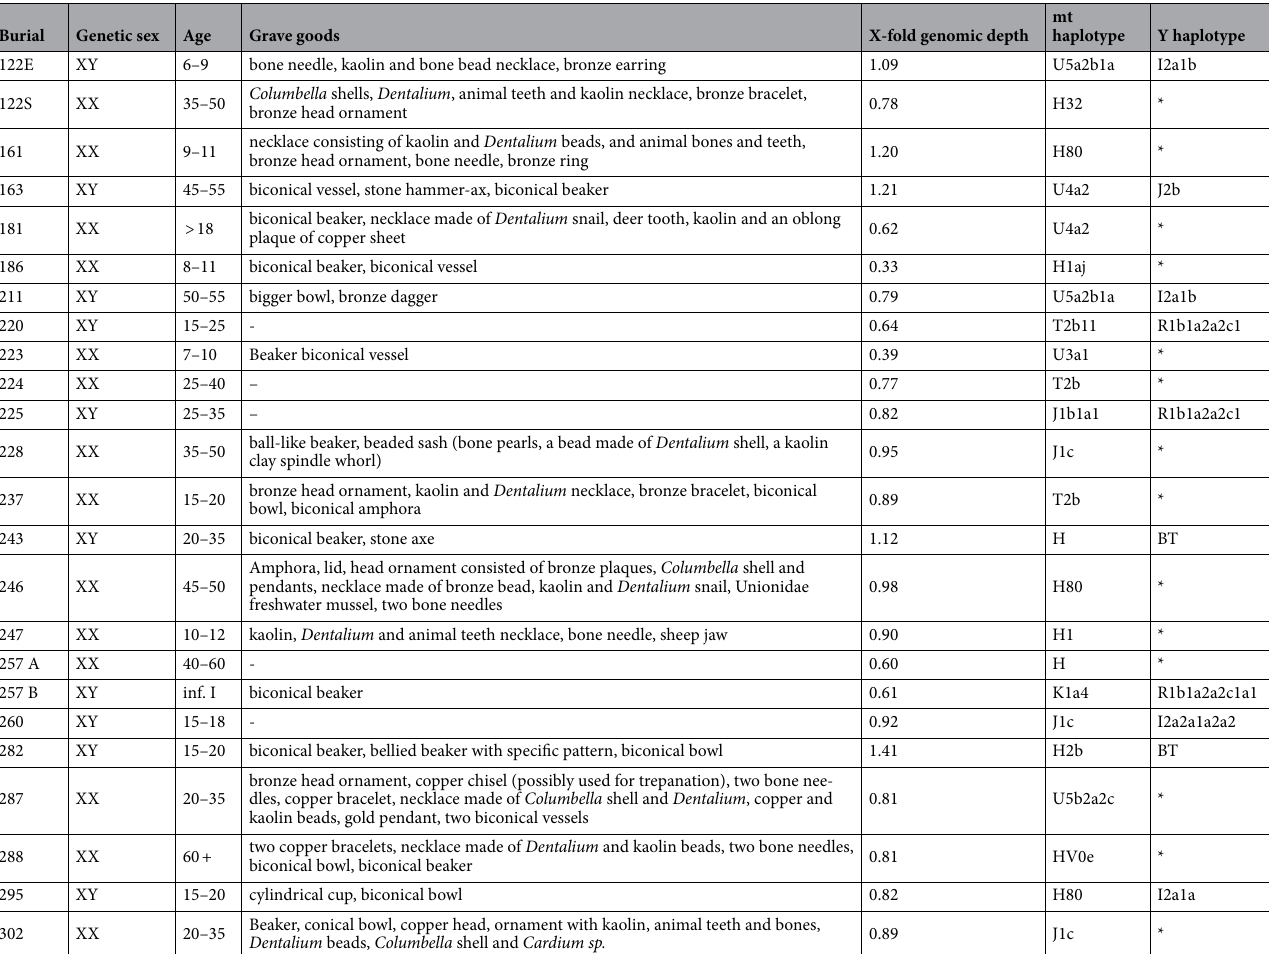
Table 1. Early Bronze Age Mokrin samples analyzed: burial information, genetic sex determination, age, grave goods, genomic sequencing coverage and uniparental haplotype